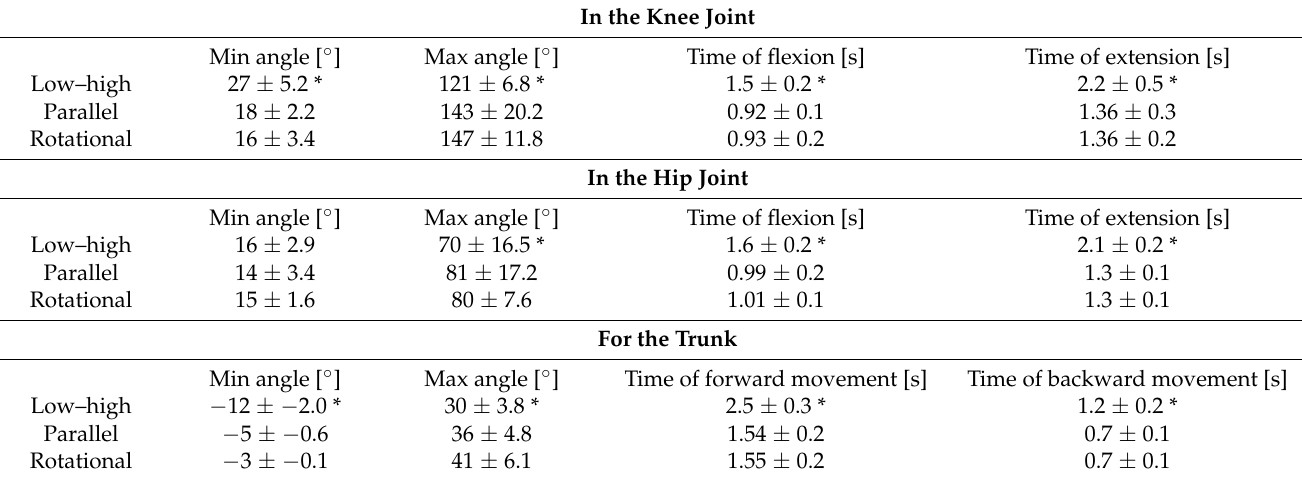
Figure 2. Velocity in the particular turns [m/s]. Table 2. The kinematic values for motion.